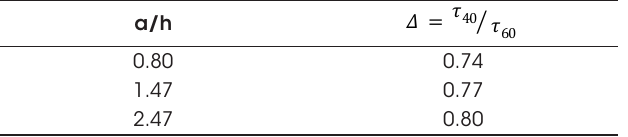
Tangential stress x ratio a/h for average stress values Ratios between tangential stresses